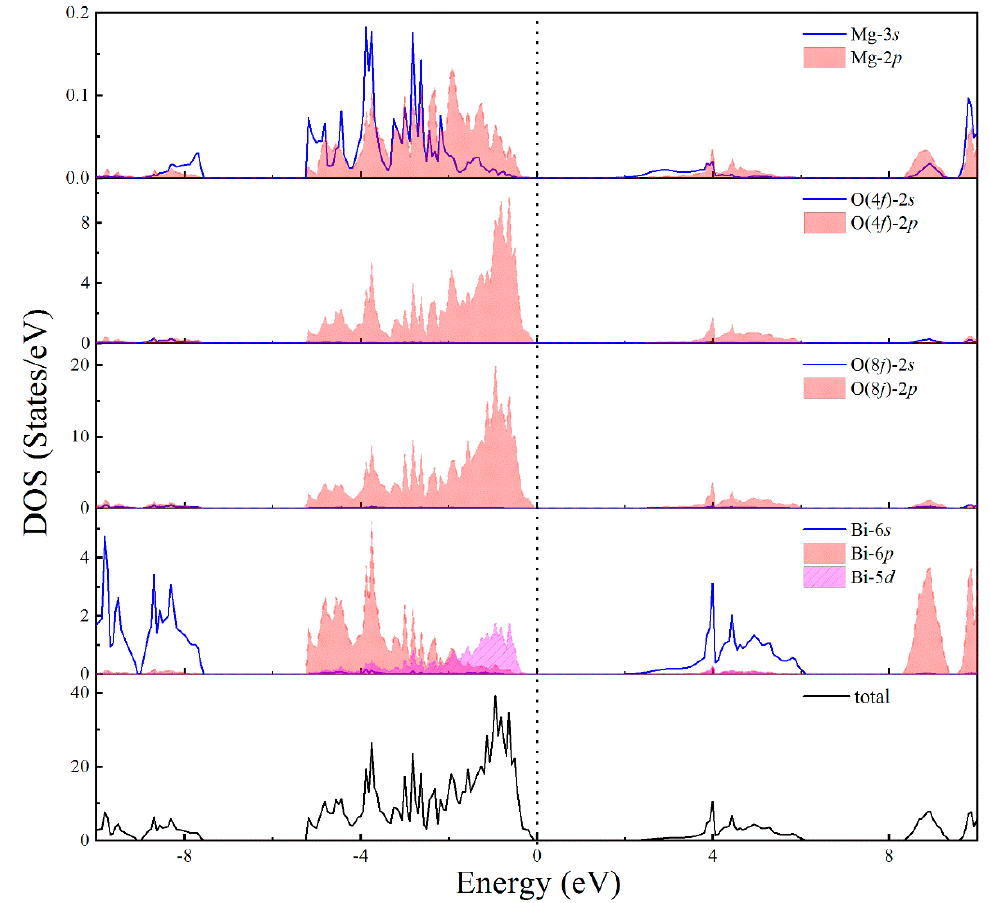
Figure 3. Calculated electronic density of states of MgBi 2 O 6 using PBE0 method.